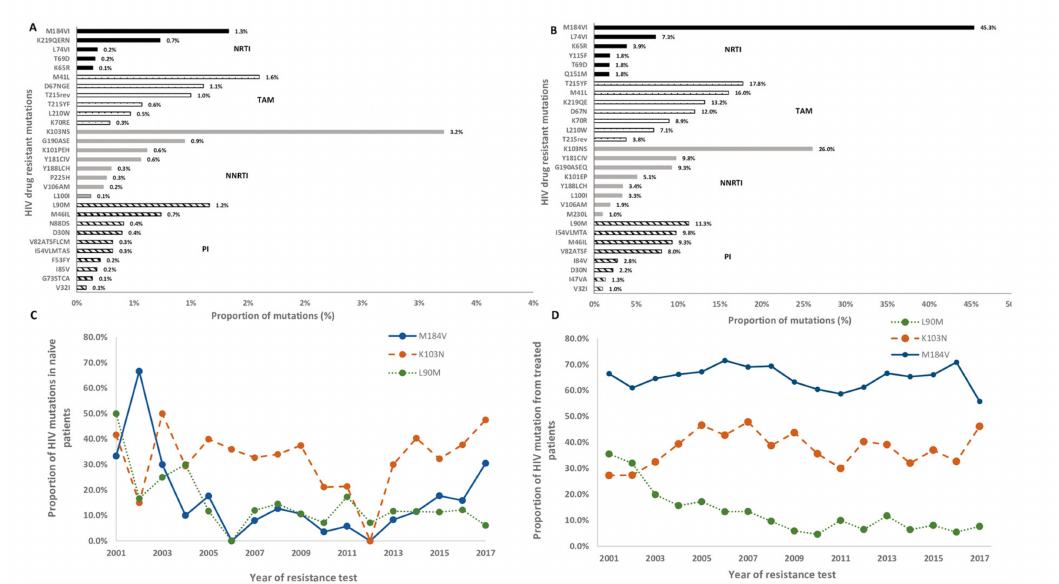
Figure 2. Proportion of resistance mutations in sequences ( A ) ART-NP and ( B ) ART-EP and proportion of M184V, K103N and L90M mutations in ( C ) ART-NP and ( D ) ART-EP over time between 2001 and 2017. TAM, Thymidine analog mutation; NRTI, nucleotide reverse transcriptase inhibitors; NNRTI, non-nucleotide reverse transcriptase inhibitors; PI, protease inhibitors. ART-NP, antiretroviral-naïve patients; ART-EP, antiretroviral-experienced